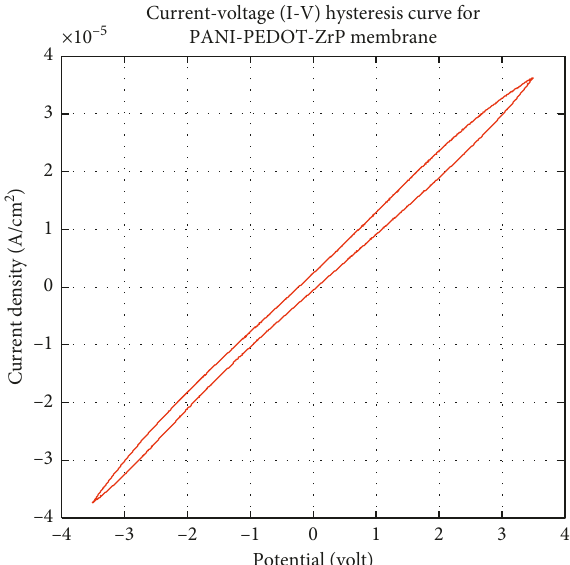
Figure 3: Water uptake of PANI/PVC-PEDOT: PSS-ZrP membrane.